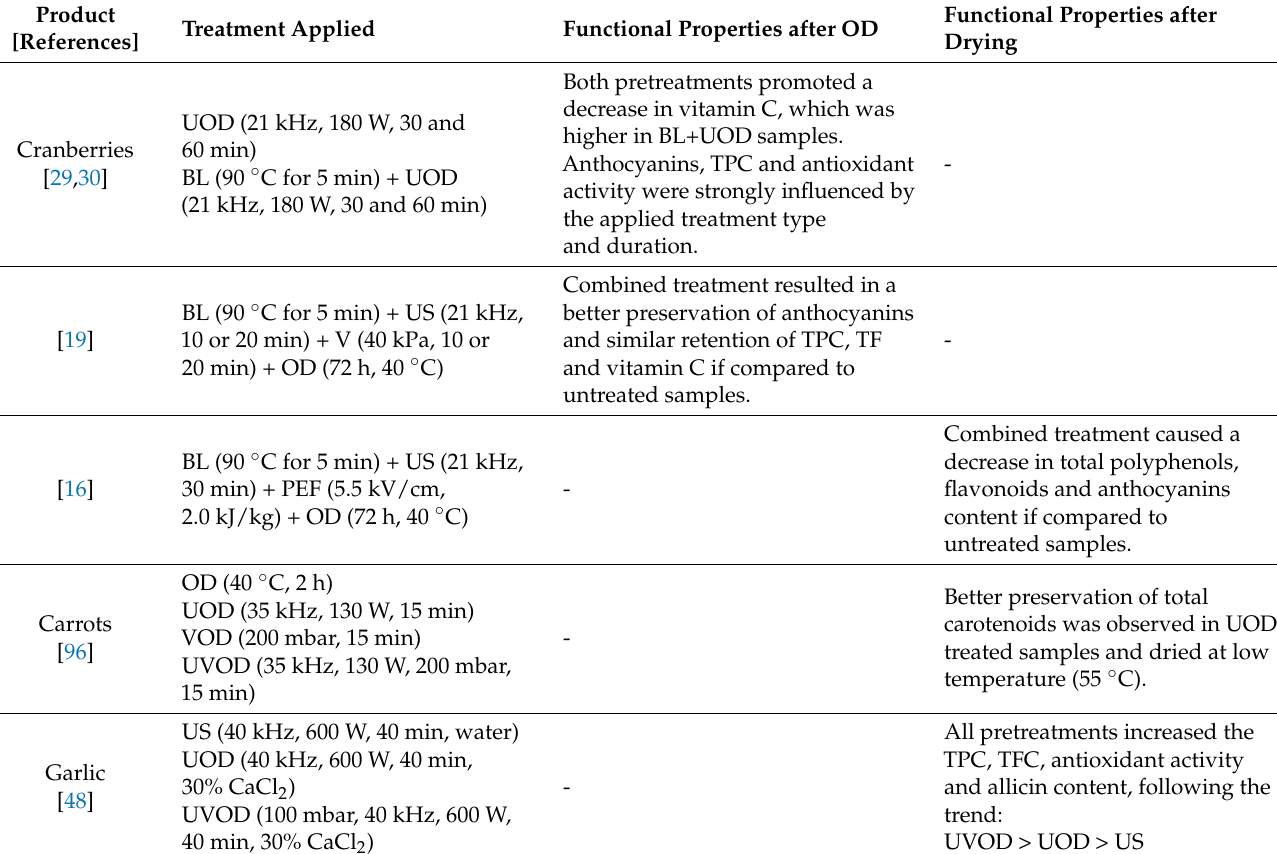
Table 2. The functional properties of products osmo-dehydrated with the assistance of